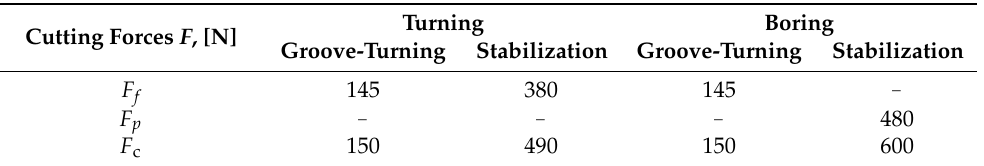
Table 1. Changing values of the cutting forces.